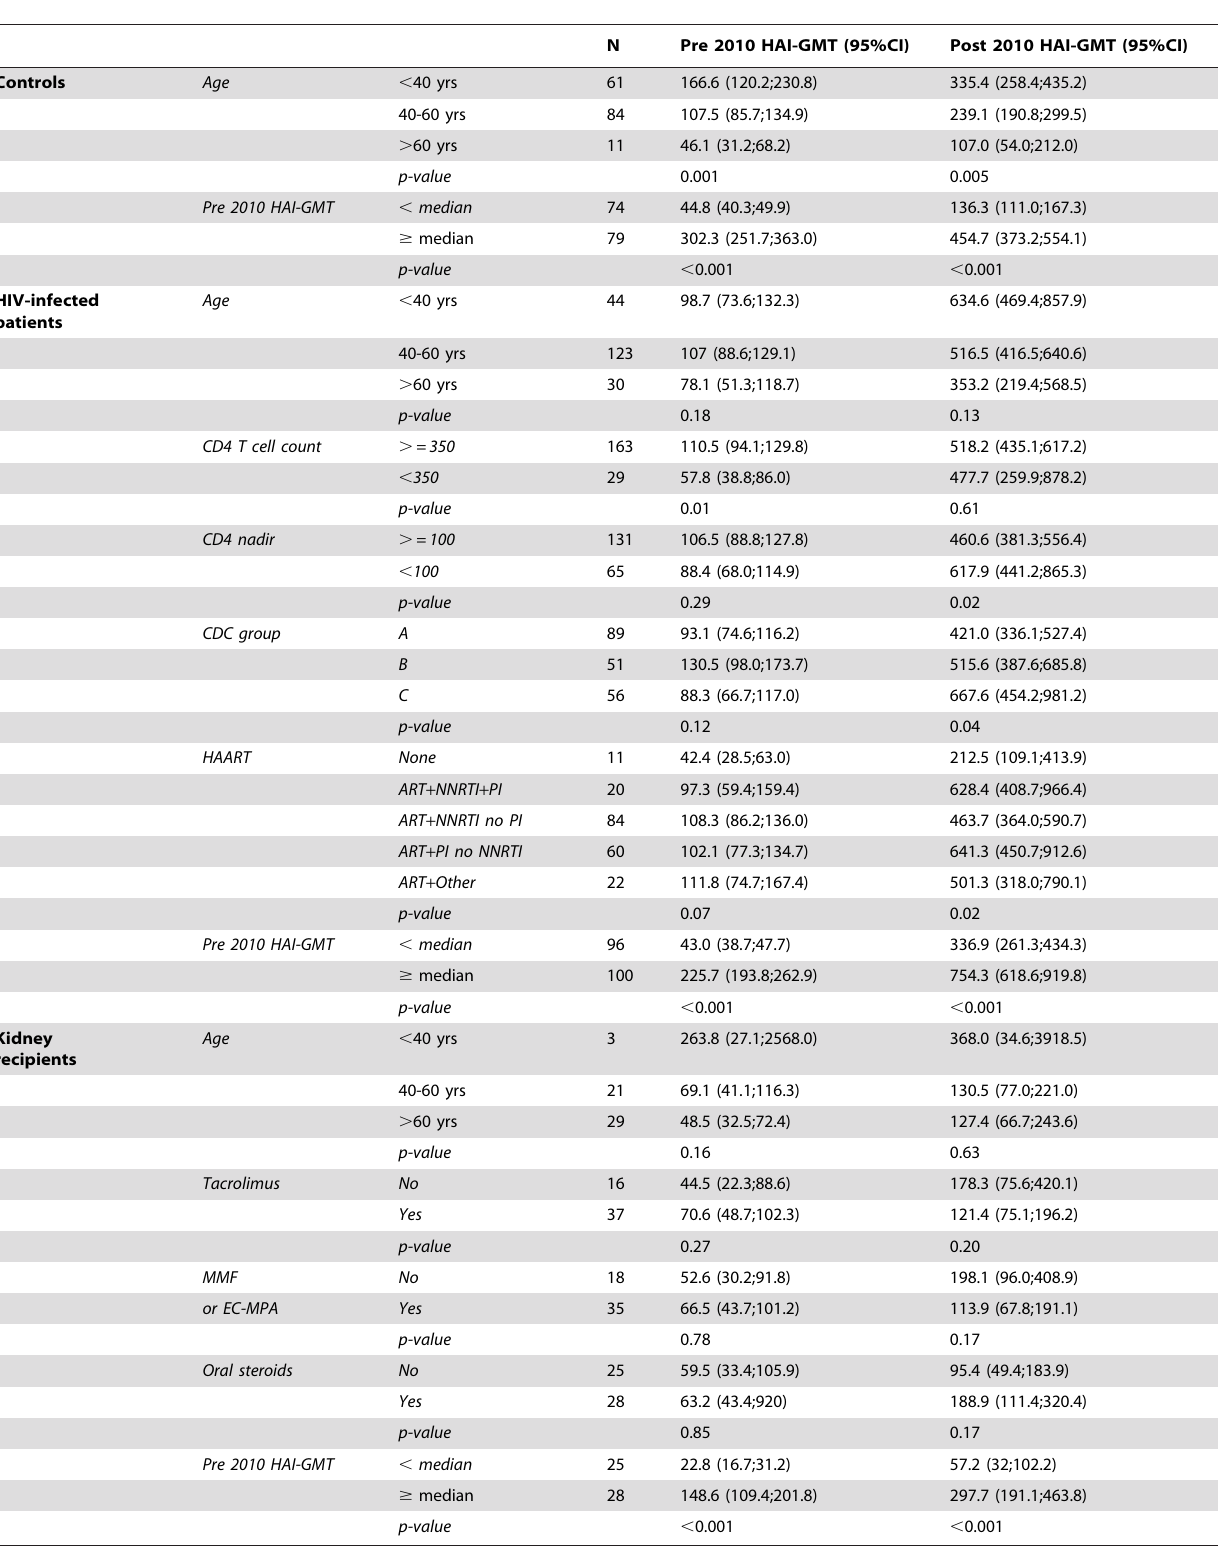
Table 3. Determinants of vaccine antibody persistence and memory responses to influenza